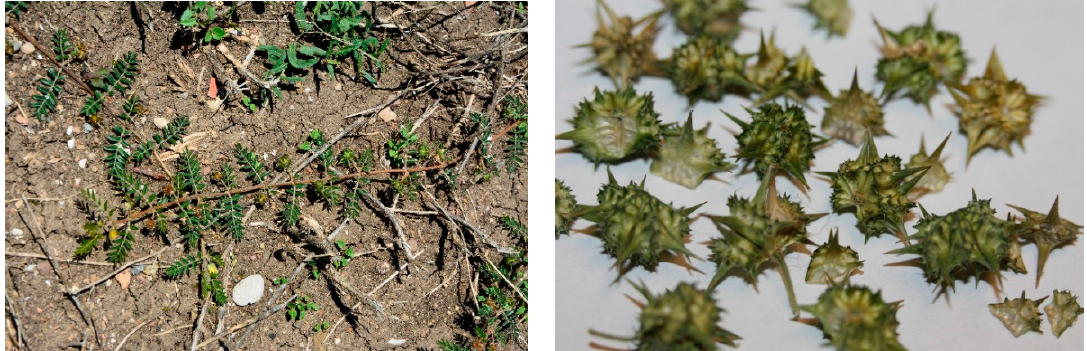
Figure 1. Tribulus terrestris